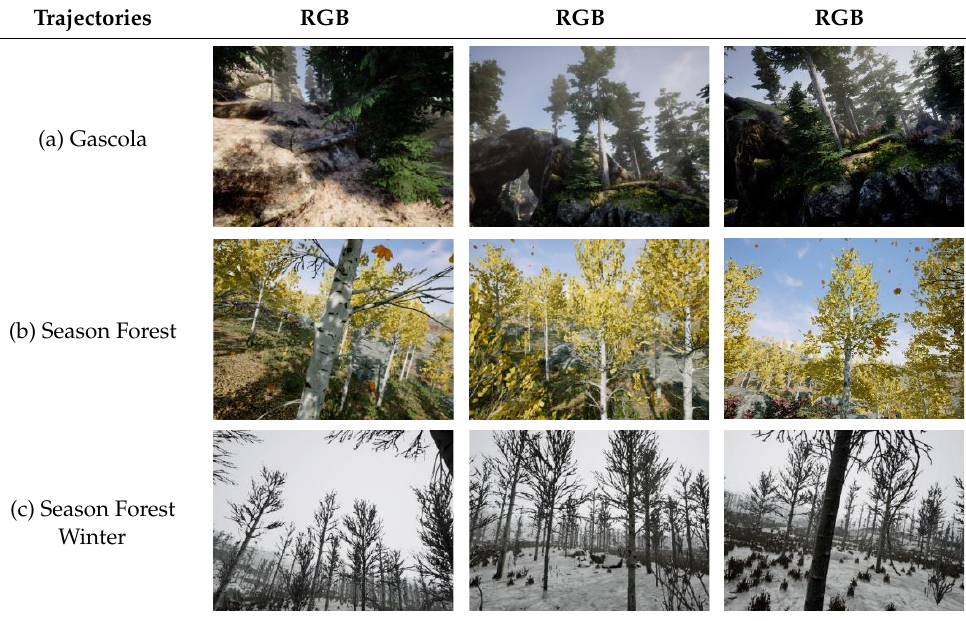
Table 3. Examples of RGB images from Tartan Air dataset: Gascola (a), Season Forest (b), and Season Forest Winter (c) trajectories.